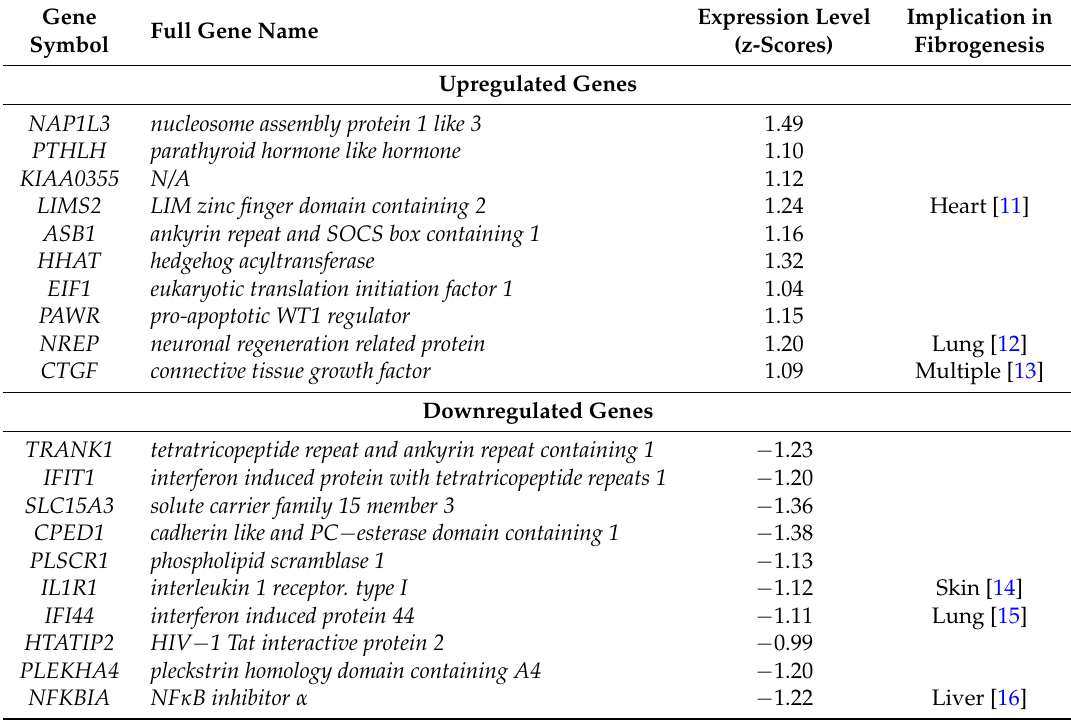
Table 2. The ten most significantly upregulated and downregulated genes in IPF fibroblasts compared with control lung fibroblasts. Expression level was defined by z-score (IPF)–z-score (Controls). N/A: not available.